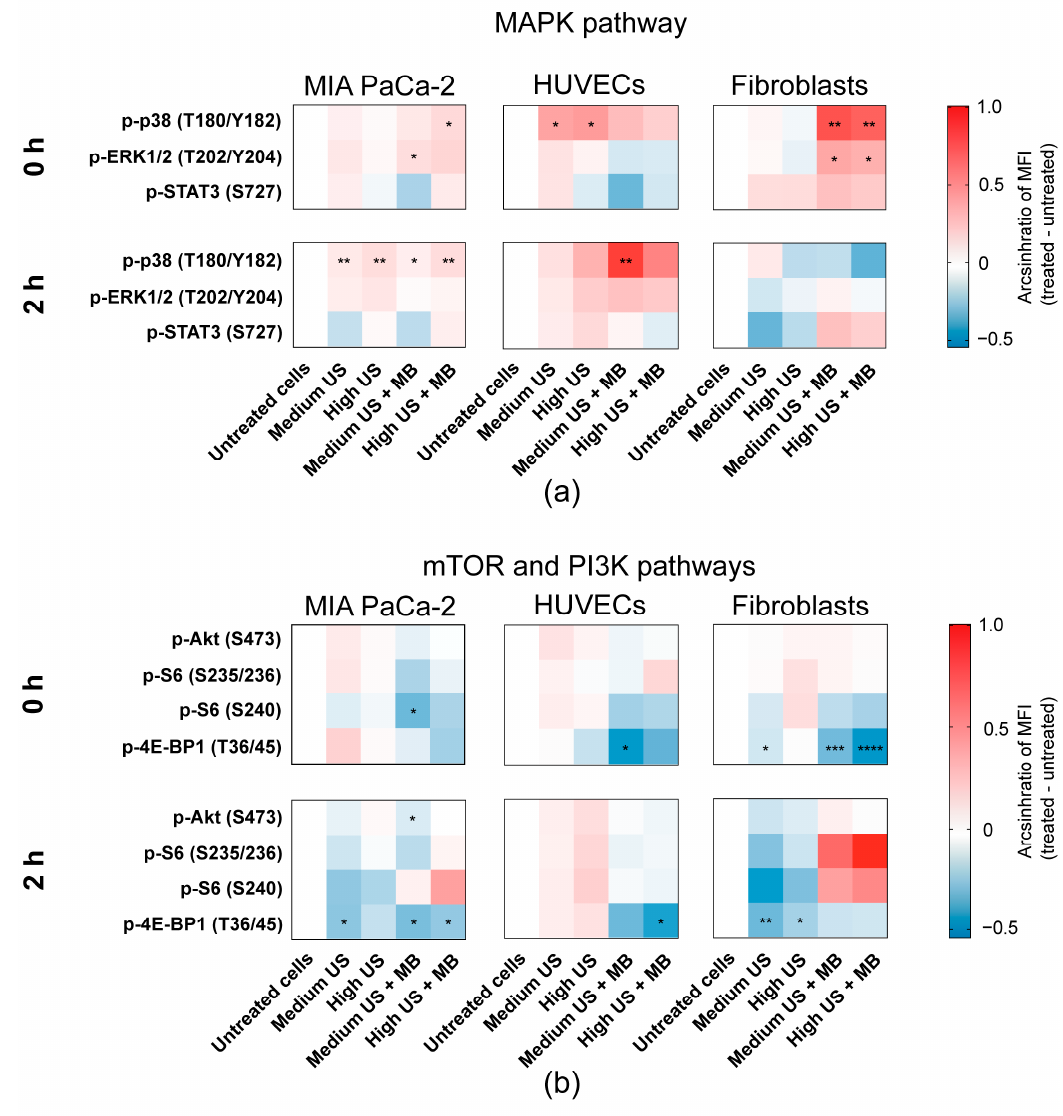
Figure 5. Intracellular signalling induced by sonoporation. Heatmaps displaying changes in phosphorylation status (shown as arcsinh ratio) of the chosen range of proteins in response to treatment with US with and without Sonazoid TM MBs. Phosphorylation status was detected immediately (0 h) and 2 h post-sonoporation. Di ff erent phosphorylation profiles were observed in the ( a ) MAP-kinase pathway (p38, ERK1 / 2 and downstream target STAT3 S727), and ( b ) mTOR (ribosomal protein S6 and 4E-BP1) and PI3K pathways (Akt). Mean ± SEM. * p < 0.05, ** p < 0.01, *** p < 0.001, **** p < 0.0001 (treated vs. untreated